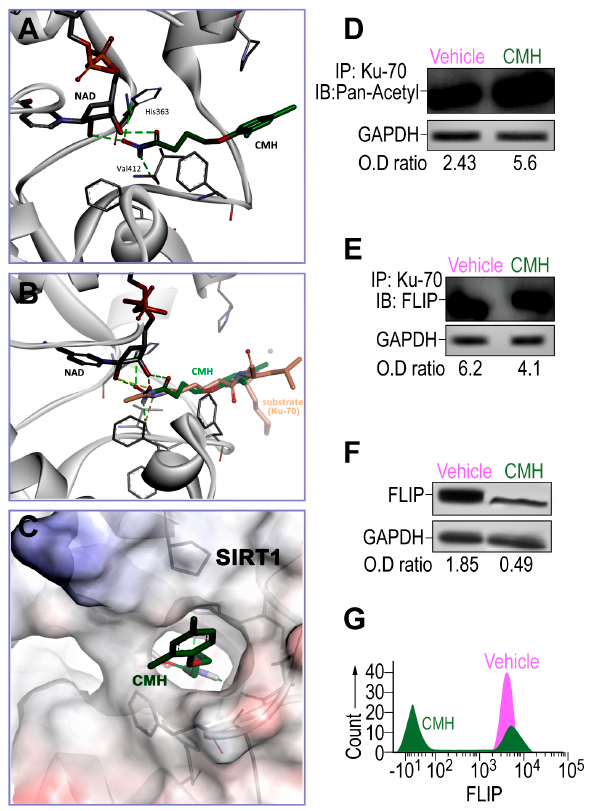
Figure 1. The effects of 4-(4-chloro-2-methylphenoxy)-N-hydroxybutanamide ( CMH) docking into SIRT1 and CMH on FLICE inhibitory protein (FLIP) expression, Ku70 acetylation, and Ku70/FLIP complex, in human idiopathic pulmonary fibrosis (IPF)-lung myofibroblasts. Docking assessment by AutoDock VINA v.1.1.2 and Western blot or in IPF-lung myofibroblast CCL-191 cell line. ( A ) CMH docks into the SIRT1 narrow hydrophobic pocket. ( B ) Crystallographic structure superimposition of CMH and SIRT1 substrate shows high similarity to acetylated lysine. ( C ) CMH in the SIRT1active site binding pocket. WB of IP-Ku70 followed by ( D ) pan-acetyl mAb IB, or ( E ) anti-FLIP mAb of CMH (30 µ M)—vs. 4% dimethyl sulfoxide (vehicle)-treated IPF-lung myofibroblast CCL-191 cell line (3 × 10 5 ). ( F ) WB and, ( G ) flow cytometry analyses using anti-FLIP mAb. Representative of five experiments. n = 4–5. * p <